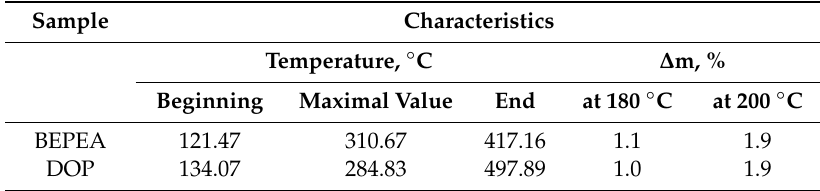
Table 3. The results of the thermal analysis of plasticizers.